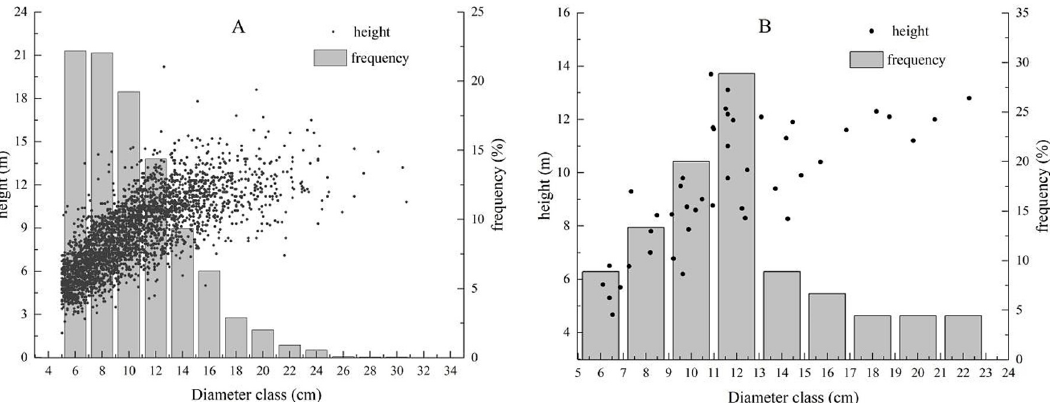
Figure 2. T he height and diameter at breast height ( D ) distribution of all the investigated trees ( A ) and the destructively sampled trees ( B ). The vertical bar represents the distribution frequency across 2-cm diameter classes.